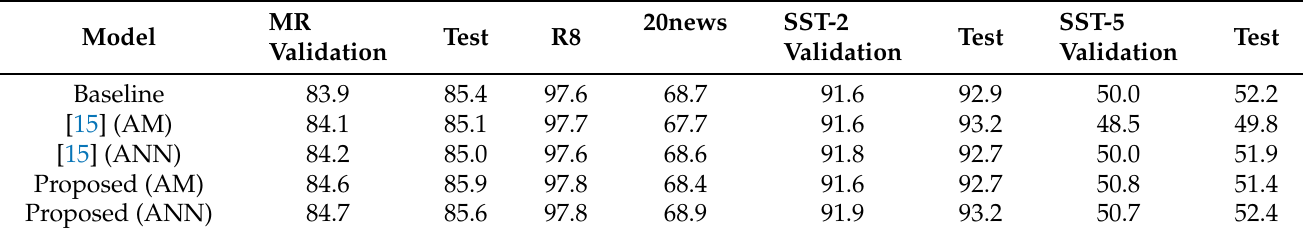
Table 3. Model performance on text classification with